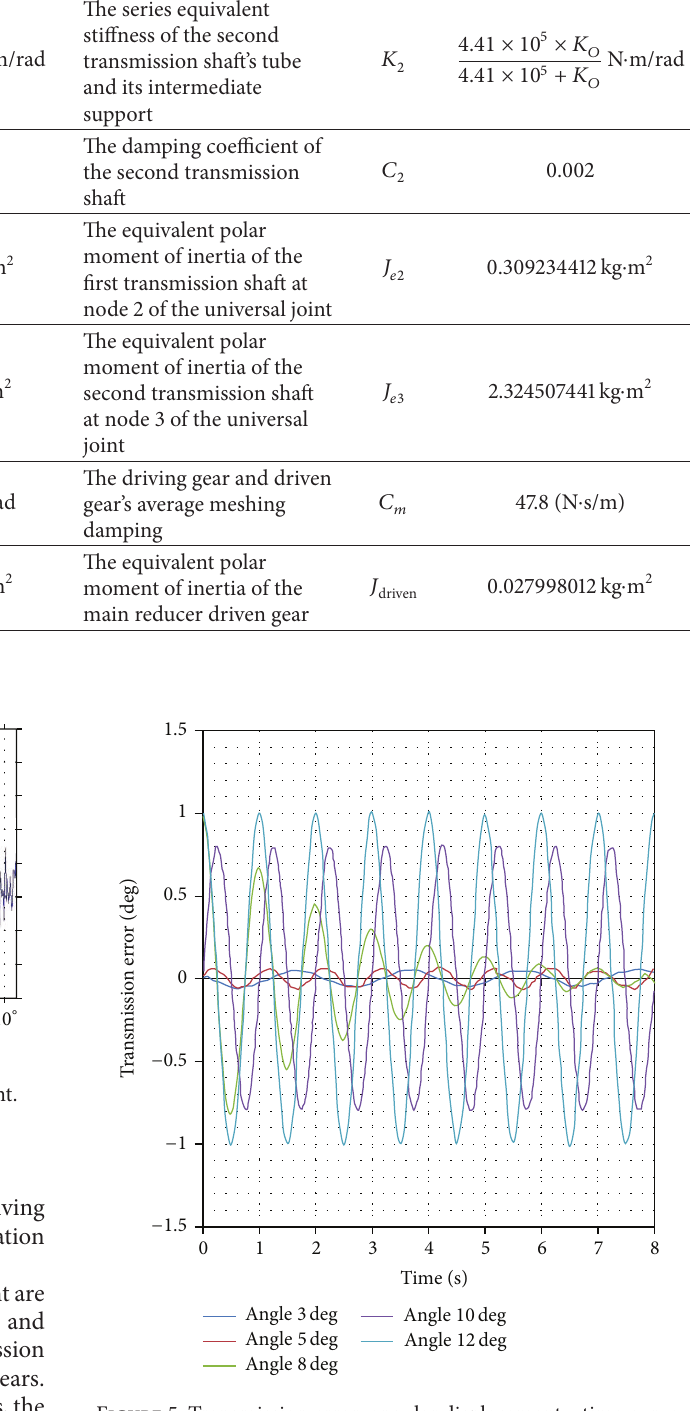
Figure 5: Transmission error: angular displacement—time curve.